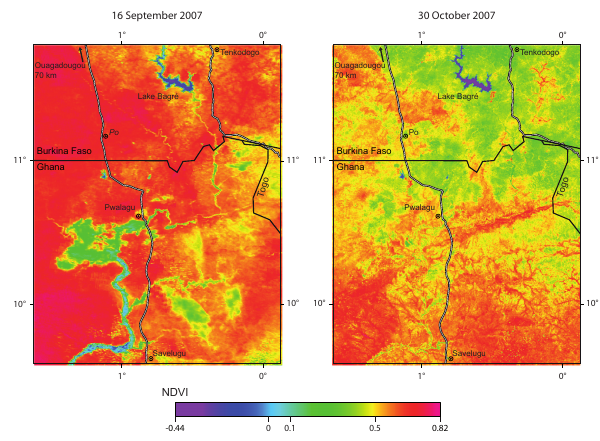
Fig. 4. NDVI along the White Volta basin in northern Ghana/southern Burkina Faso at 16 September and 30 October 2007 as derived from MODIS data (based on Paeth et al.,